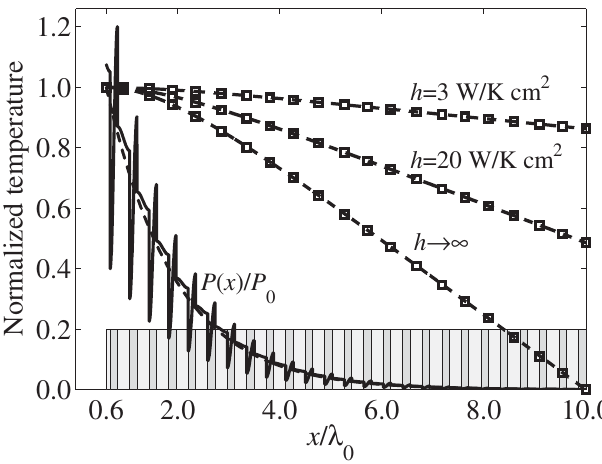
FIG. 5. Temperature profile for different values of h in the silica-zirconia structure, the parameters of which are given in Table II. For each value of h , the dashed line is the approximate curve, and the exact solution is indicated by square markers. The dissipated power profiles, approximate (dashed line) and exact (solid line), are also plotted. All quantities are normalized by their maximal approximate